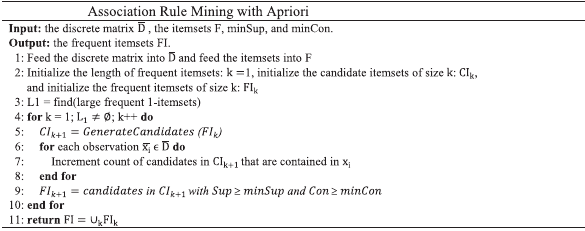
Algorithm 2. : Association Rule Mining with Apriori.